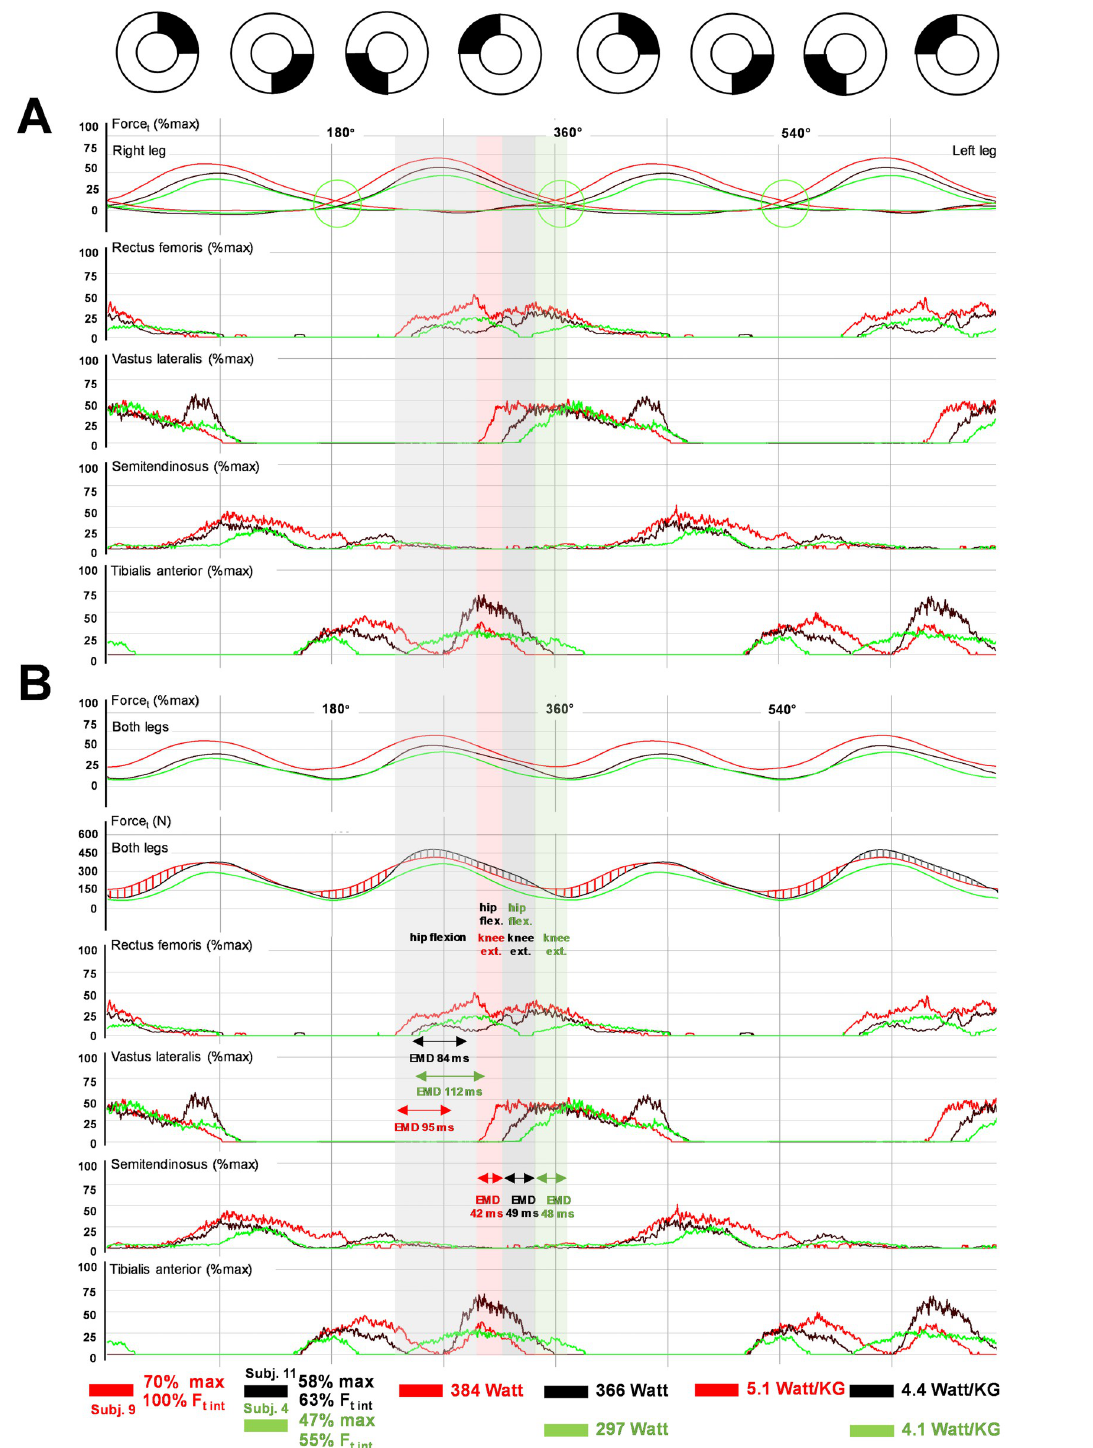
Fig 4. Examples of RF/VL recruitment pattern and force development at the TDC for subjects at different performance levels in CP-tests. (A) Averaged bi-pedal crank force and EMG data across two pedal cycles (0–720˚) for athletes with a similar, high MLSSw (subject 9, red) and subject 11, black) and a lower MLSSw (subject 4, green). Note the vertical crossing points of the tangential force (Ft) and the delay at the TDC (Delay Ft crossing = DFC) at 180˚/360˚/540˚. Although the DFCs of subjects 9 and 11 hardly differ (1.4˚/ 2.4˚), force development of subject 11 is clearly delayed in Q1. The high DFC of subject 4 (8.6˚) results in an even more